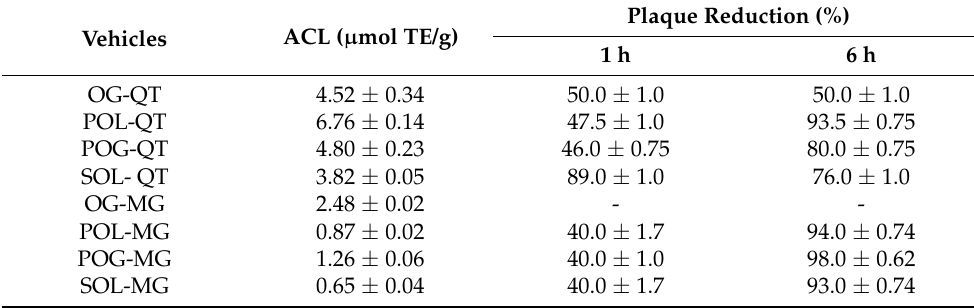
Vehicles Table 4. Antioxidant and virucidal parameters of the indicated formulations. Vehicles